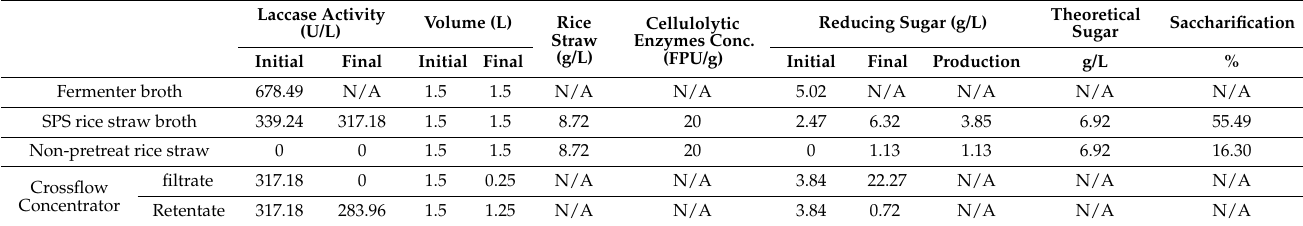
Table 6. Reducing sugar production from non-pretreated and pretreated rice straw.